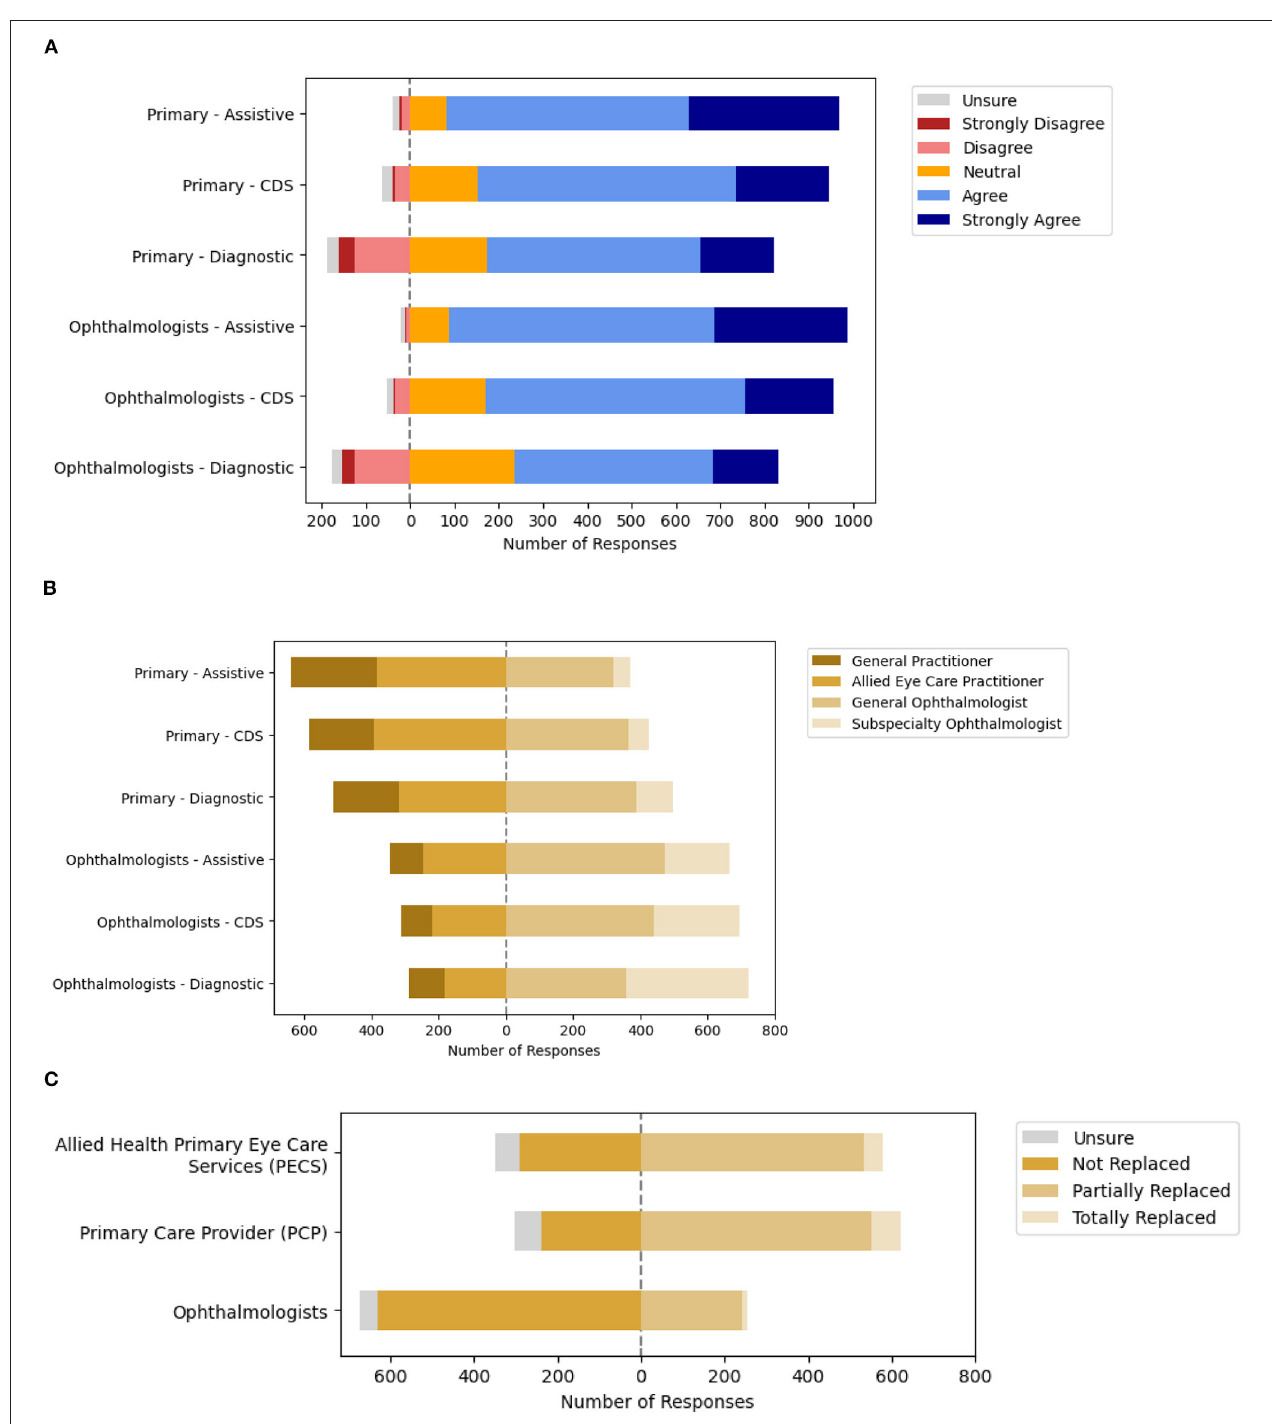
FIGURE 2 | Ophthalmologists acceptance of artificial intelligence (AI) based on the software as a medical device (SaMD) regulatory framework. (A) Acceptance of clinical AI based on significance of information and intended user. (B) Acceptable level of error based on significance of information and intended user. (C) Anticipated impact of clinical AI on professional